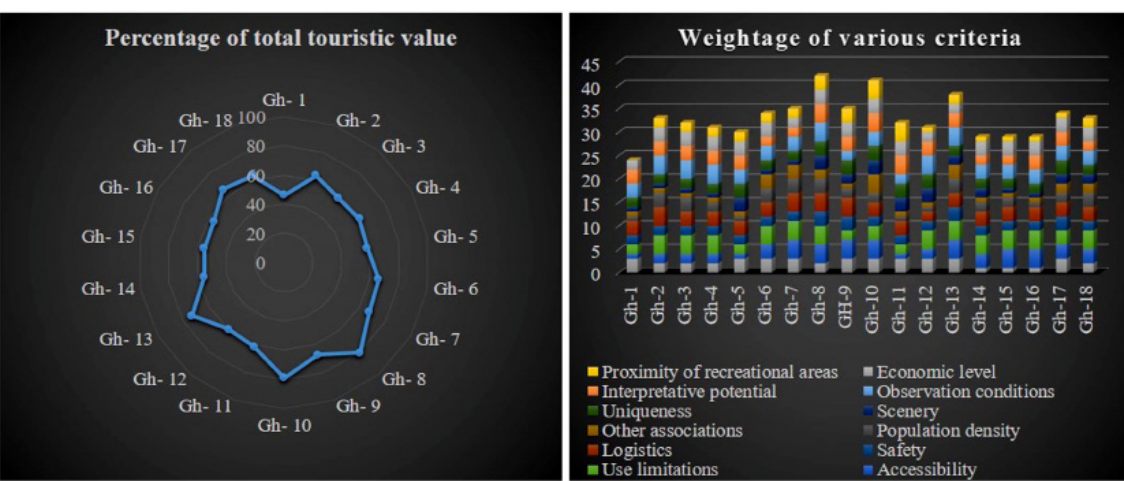
Figure 14. Assessment of the 18 geosites of Kachchh Province, Gh-1 to Gh-18, for touristic value. Percentage of the touristic value (left) and weighting of various criteria of touristic value (right).